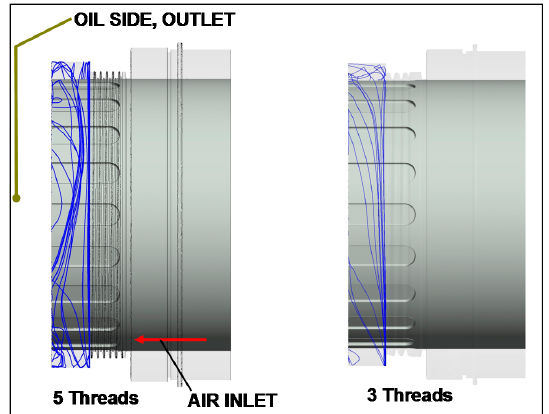
Figure 20. Oil trajectories at 15,000 rpm and different number of threads.